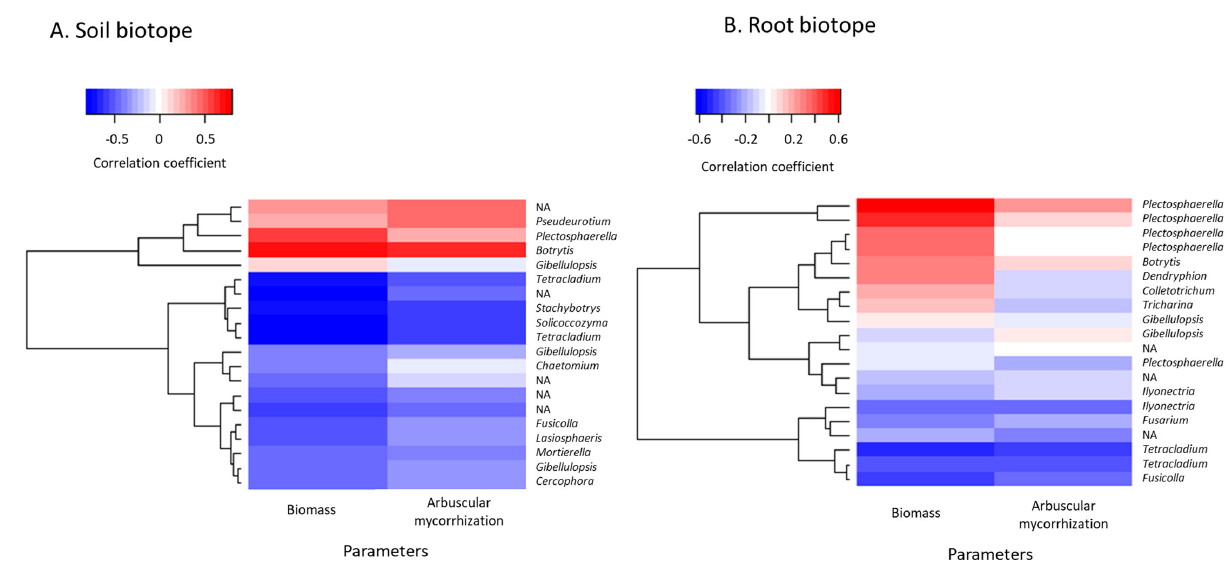
Figure 6. Heatmap representation based on the correlation coefficients between clary sage biomass (dry weight) or arbuscular mycorrhization and the 20 most represented fungal ASVs from the ITS data set in soil ( A ) and root ( B ) biotopes. They respectively belong to 12 and 10 fungal genera. NA: non-assigned.